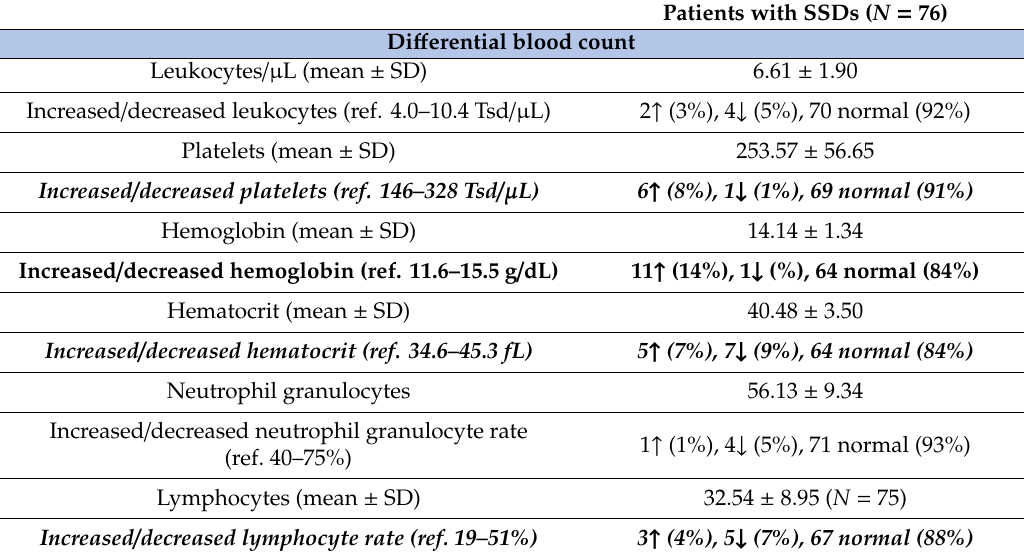
Table 3. Basic laboratory analyses in patients with schizophrenia spectrum disorders (SSDs). Values with alterations in > 10% are marked in bold, parameters with changes in > 5% are written in bold and